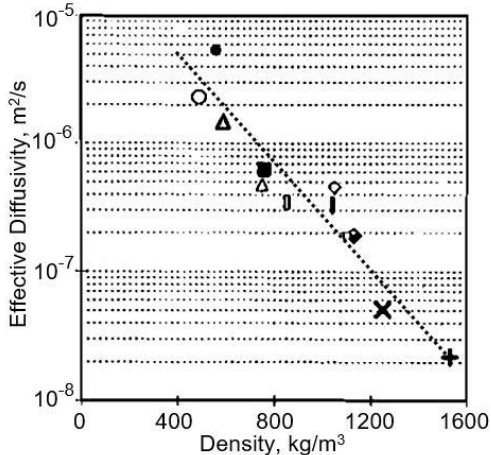
Figure 8. Effective water vapour diffusivity as a function of the density of the paper sheet. Reprinted with permission from [242]. Copyright 1993: Taylor and Francis.